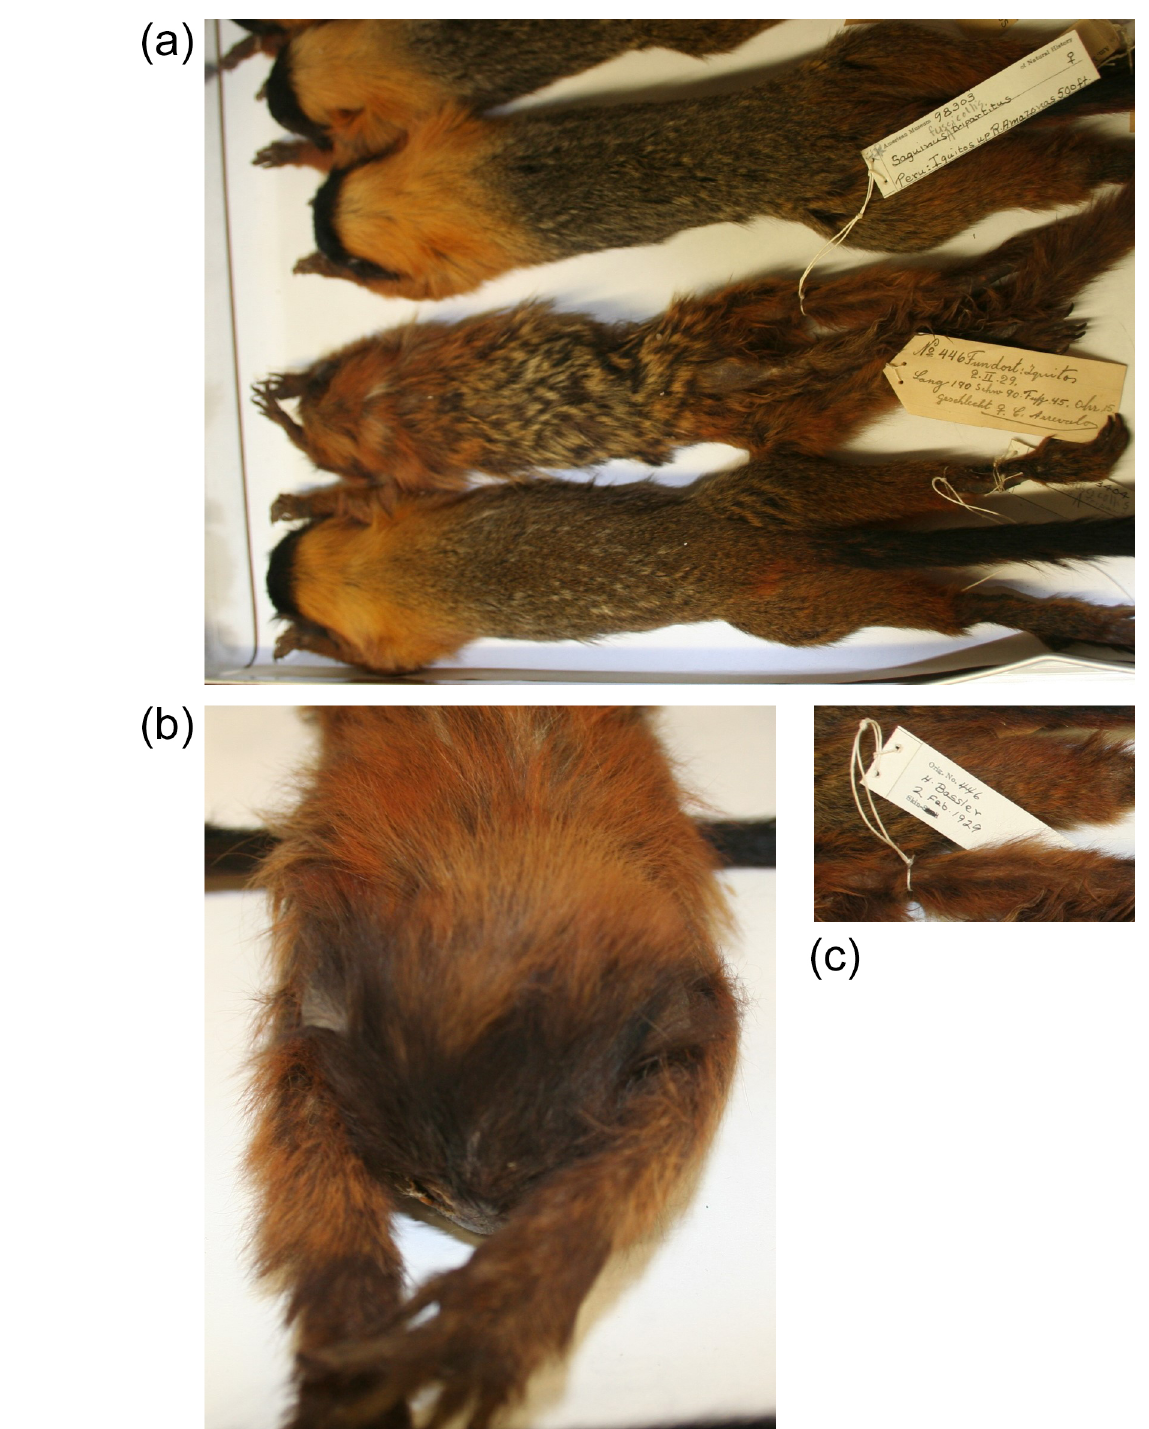
Figure 1. (a) Specimens of Saguinus fuscicollis tripartitus (above and below) and the doubtful specimen AMNH 98303 (centre). (b) Frontal view of AMNH 98303. (c) Backside of the tag. Photos: Christian Matauschek.